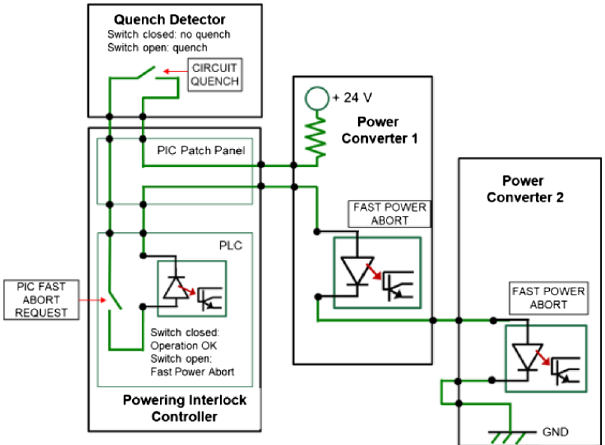
FIG. 3. The open signal path principle for beam permit trans- mission in Linac4, with Master and Slave Beam Interlock Controllers (BIC).